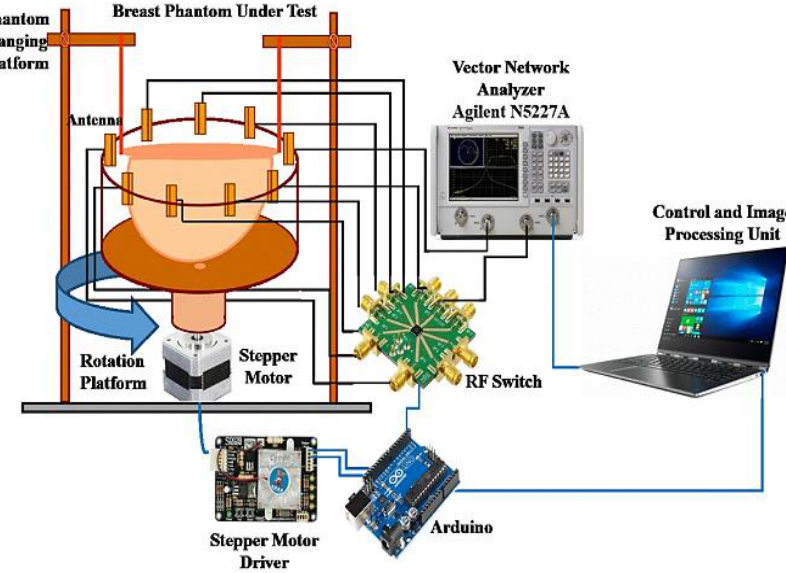
Figure 9. A conceptual view of MWT experimental setup [81].